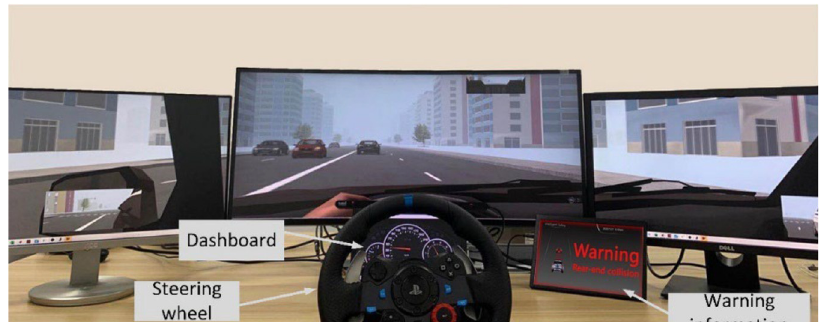
Figure 1 Experiment